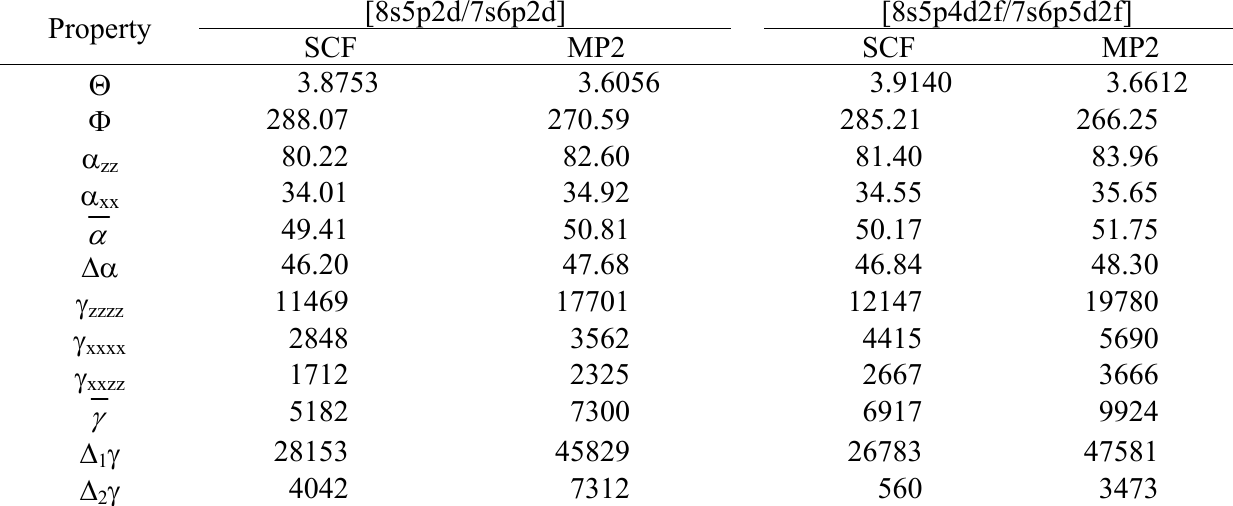
Table 2. Electric properties of ClCCCl a .